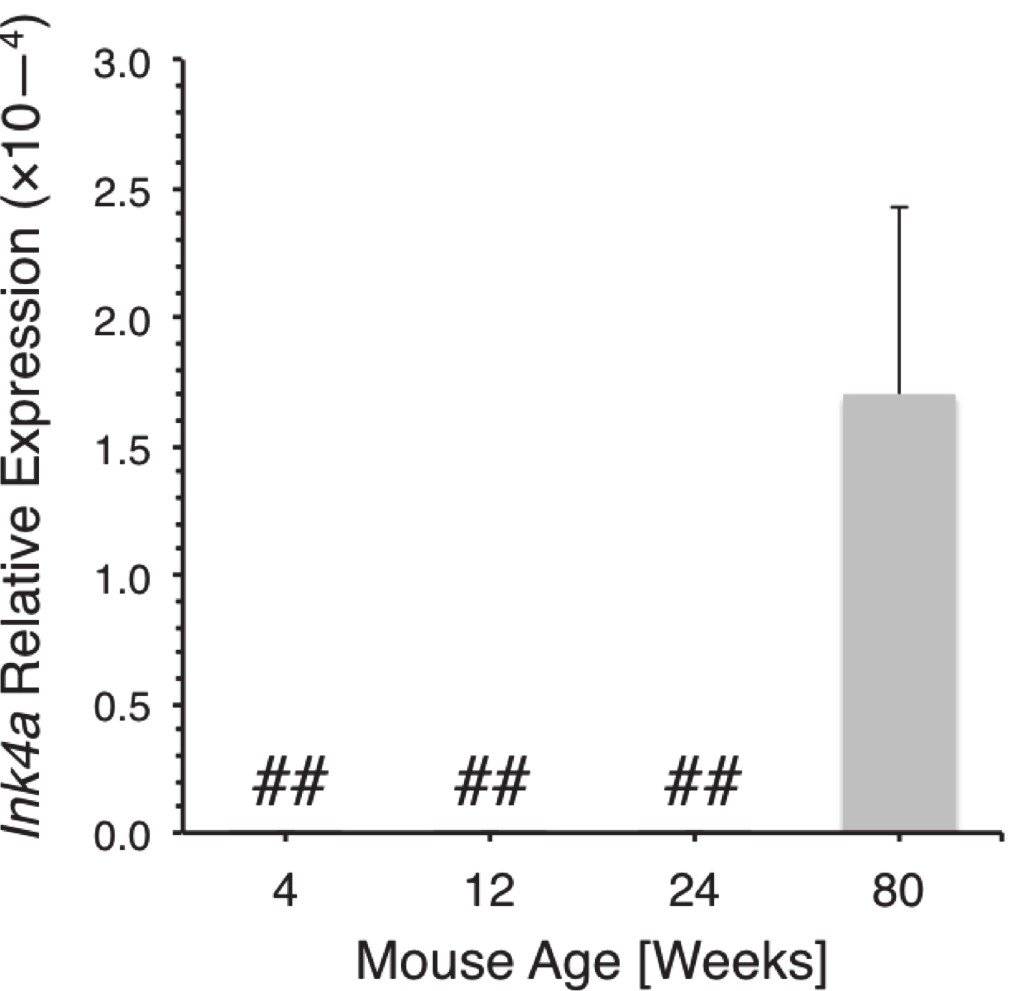
Fig 5. Ink4a is not expressed in neonatal ETP. Ink4a expression as measured by qPCR relative to Gapdh in ETP purified from the thymus of two 4 week old, three 12 week old, three 24 week old, and eight 80 week old mice. Data represent mean ± SD. Thymii from the various aged mice were pooled and ETP were isolated. All reactions were run twice on each